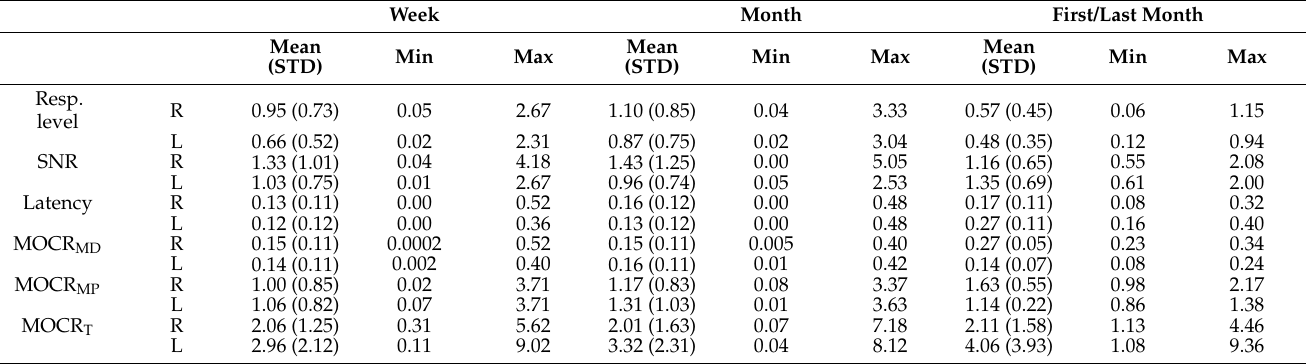
Table 2. Average week-to-week and month-to-month differences (absolute values, unsigned)